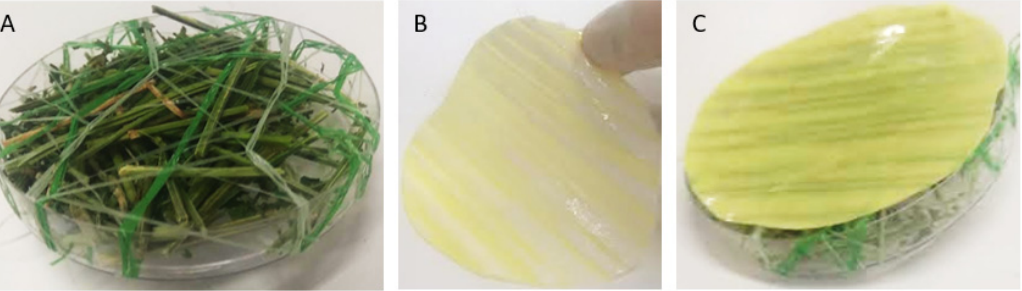
Figure 2. Net covered Petri dish prefilled with water and hay ( A ), hydrogel side of coated PE sheet ( B ) and the covered dish with the hydrogel oriented towards the hay ( C ). ( B ) and the covered dish with the hydrogel oriented towards the hay ( C